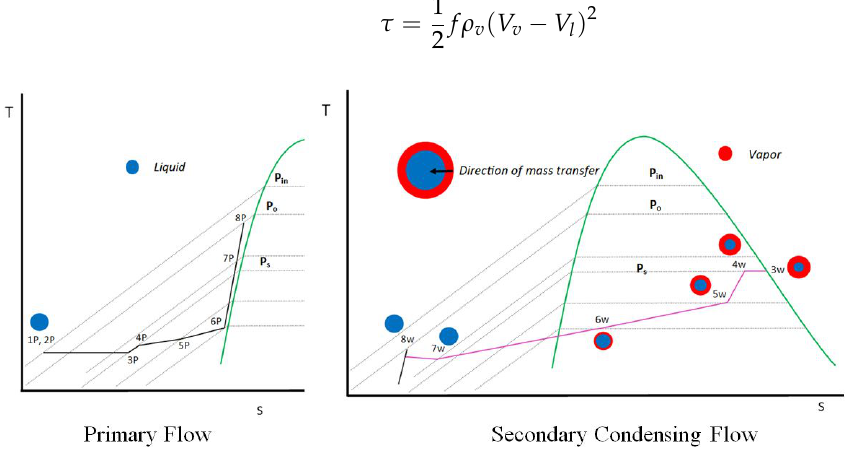
Figure 2. T-S diagram estimated for the